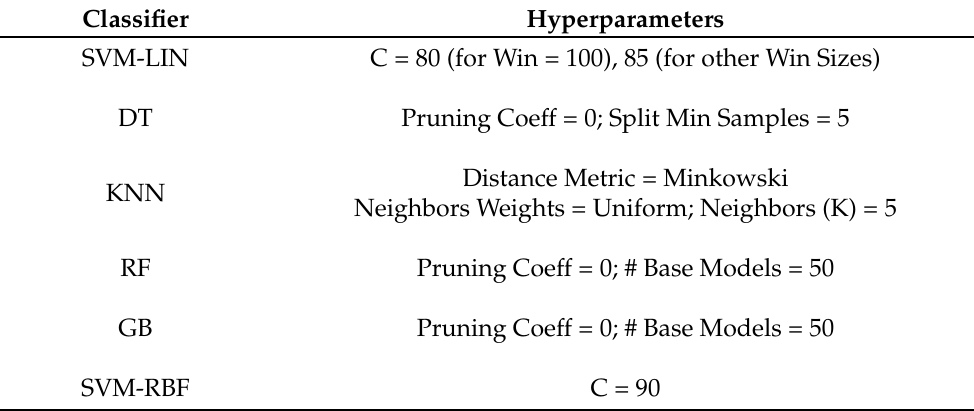
Table 3. Grid search optimal hyperparameters for classification models using the sEMG data of Participants 4, 5, and